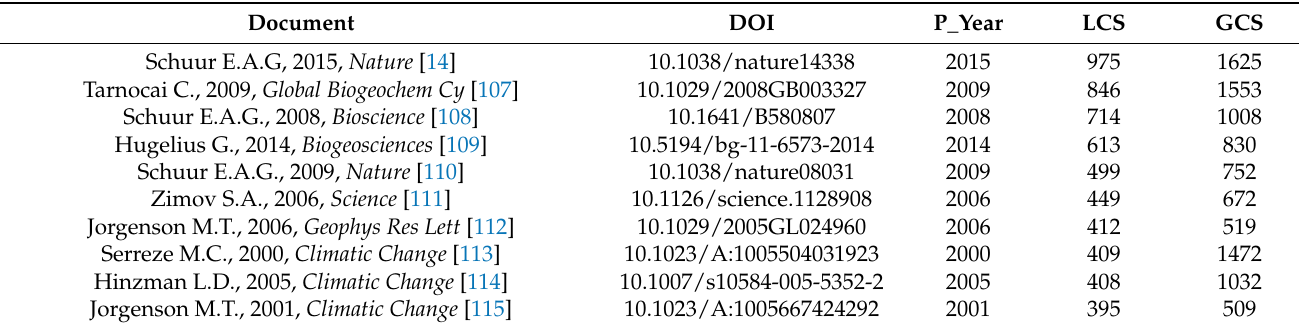
Table 7. Top 10 documents ranked by the local citation score.